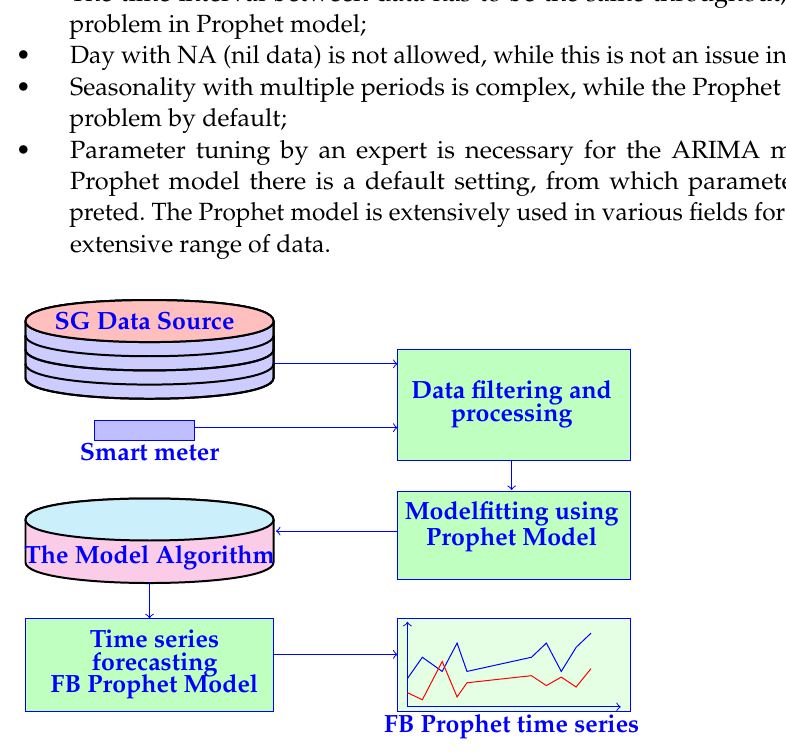
Figure 1. The workflow diagram of the Prophet model for the prediction of demand